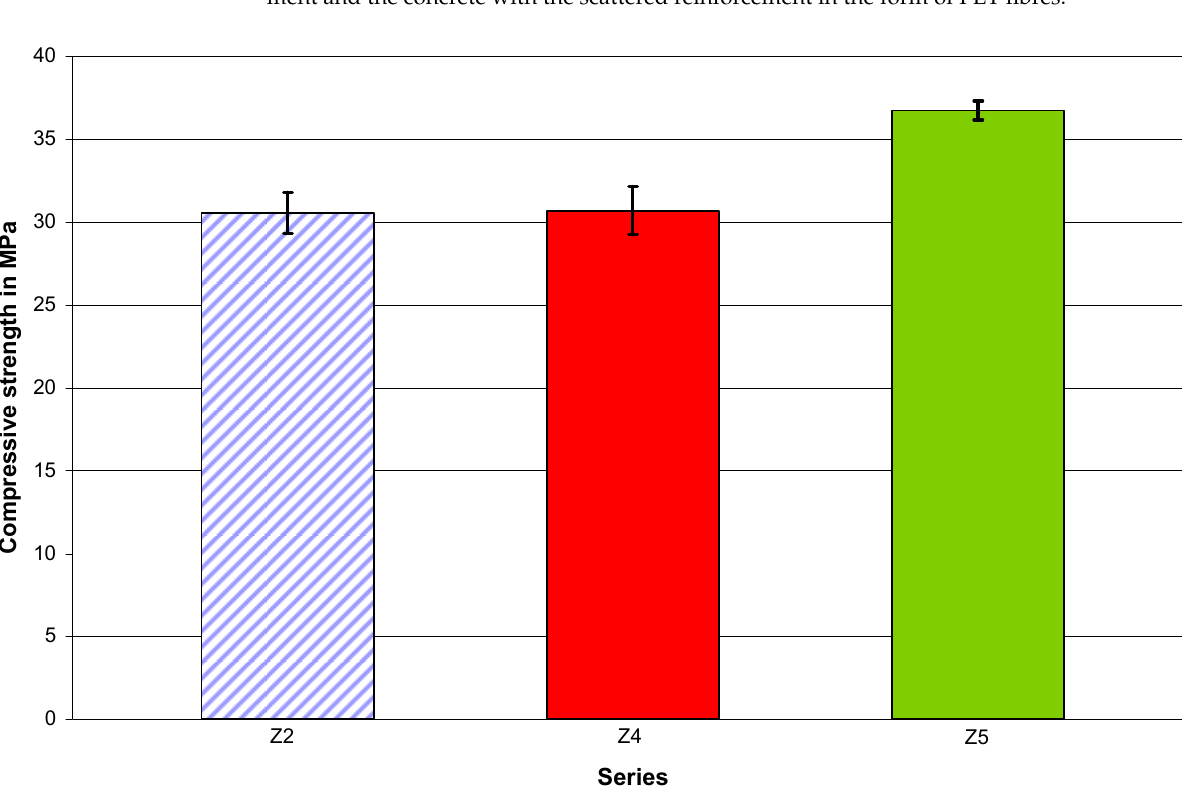
Figure 9. Results of the compressive strength test for the concretes with the scattered reinforcement in the form of PET fibres (length 62 mm), polypropylene fibres, and steel fibres.